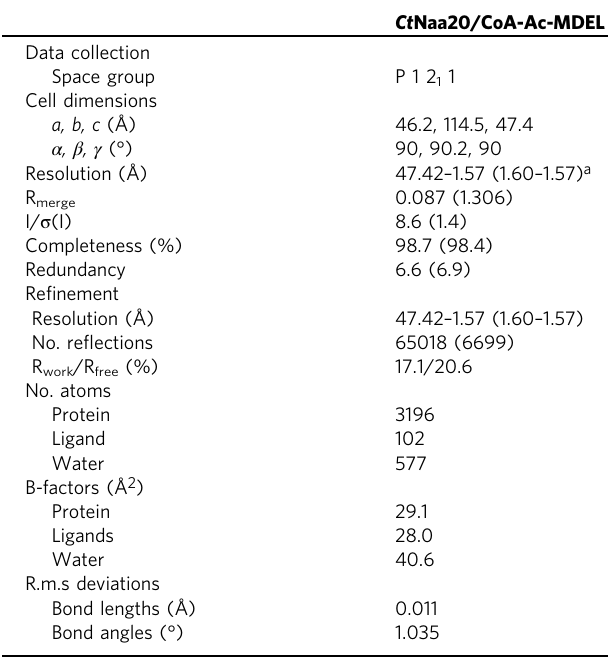
Table 1 Data collection and re fi nement statistics (molecular